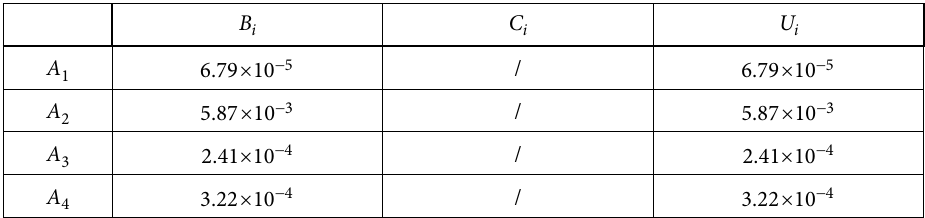
Table 8. The ranking results of the DHHFL–MULTIMOORA method DHHFLRS DHHFLRP DHHFLMF Rankings 2 3 4 1 A A A A    4 2 3 1 A A A A    2 4 3 1 A A A A  